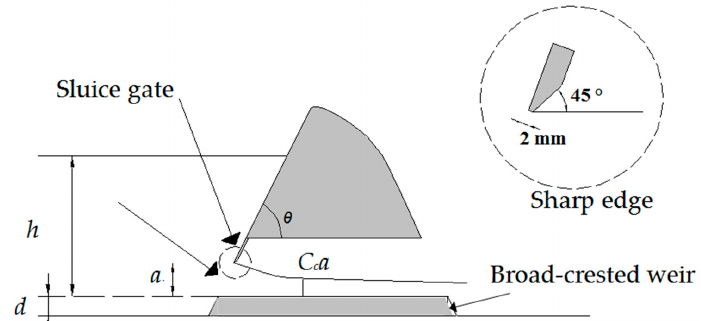
Figure 1. Definition sketch of sluice gate (vertical section along the middle of the gate opening of width b ), with notation.